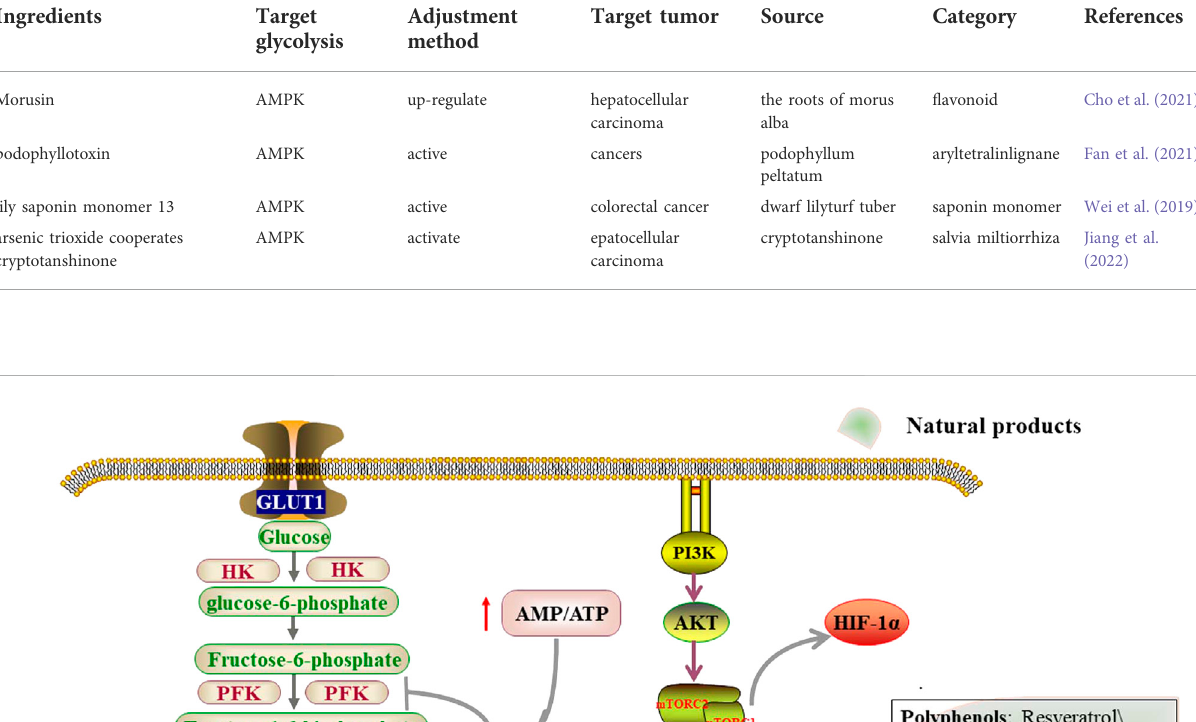
TABLE 3 Natural products regulate glycolysis by targeting AMPK in cancer.